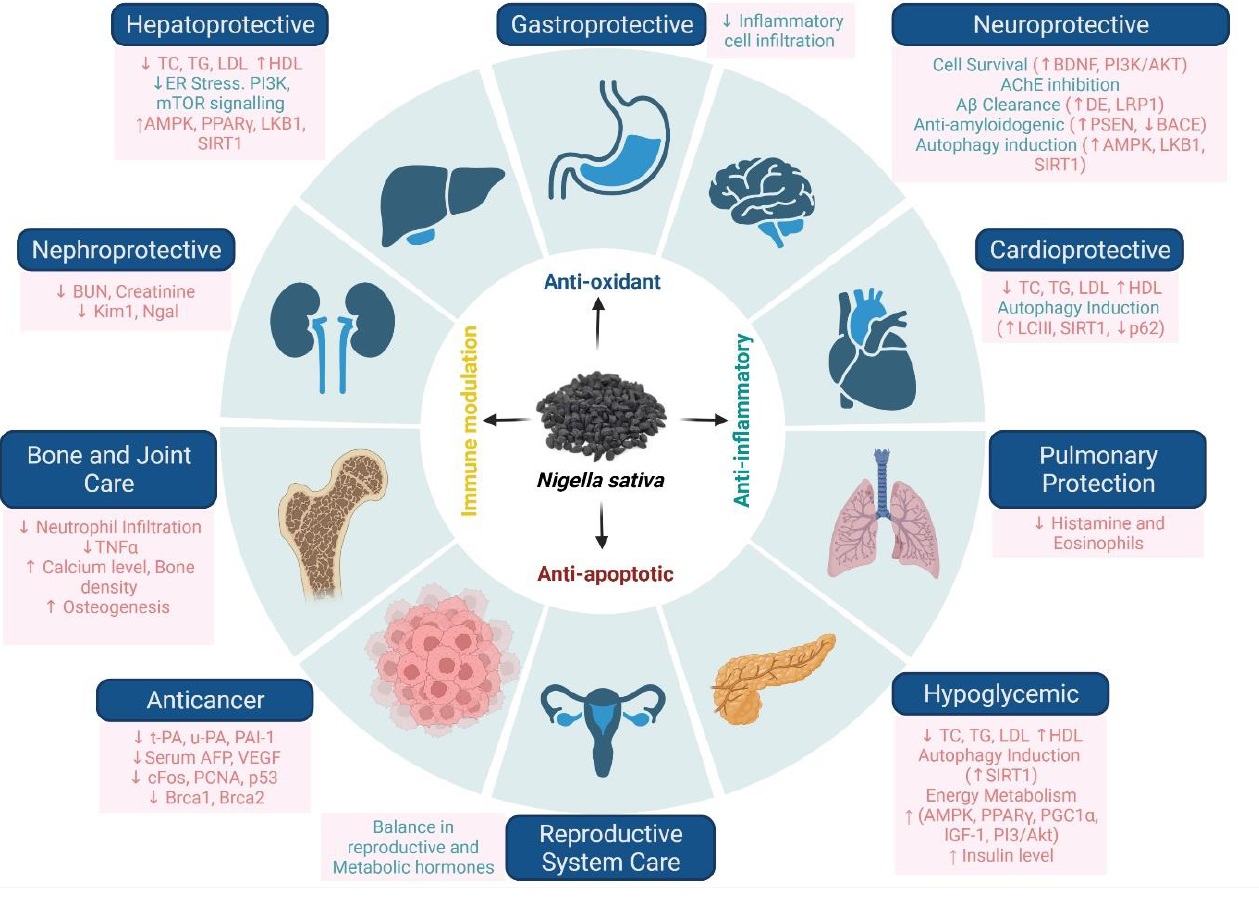
Figure 3. Detailed pharmacological profile of N. sativa and summary of its protective mechanisms in various organ-based diseases. Up arrow ( ↑ ) indicates increase in level and down arrow ( ↓ ) indicates decrease in level. “ Image created with BioRender.com ” .